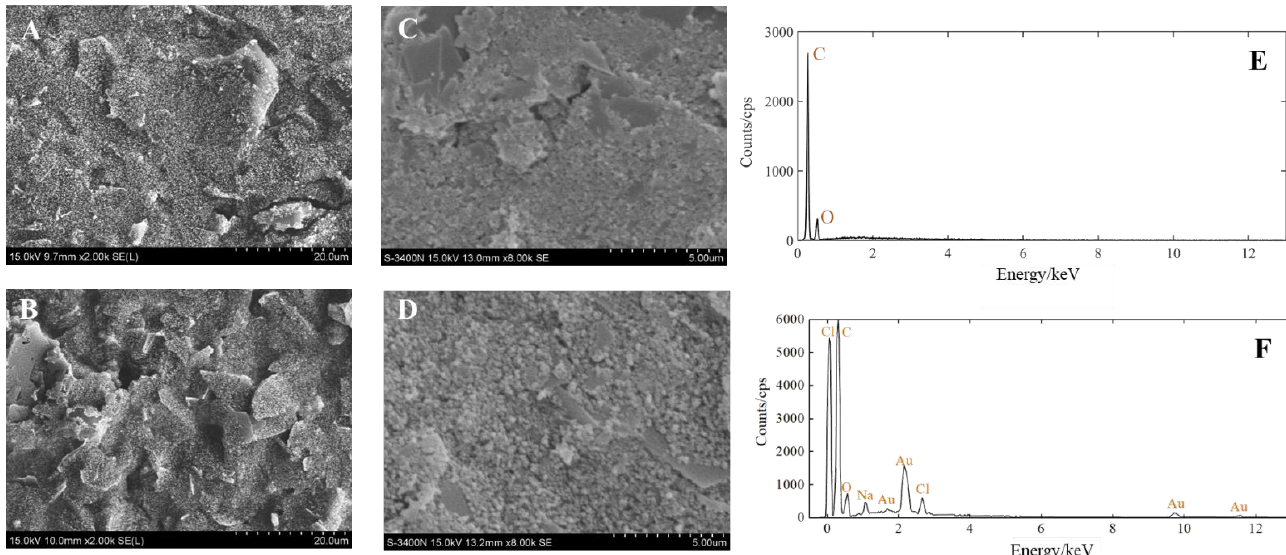
Figure 4. ( A ) SEM image of the SPE (2000 times ). ( B ) SEM image of the SPE after AuNPs modification (2000 times ). ( C ) SEM image of the SPE (8000 times ). ( D ) SEM image of the SPE after AuNPs modification (8000 times ). ( E ) EDX spectrum of the bare electrode. ( F ) EDX spectrum of the AuNPs-modified electrode.